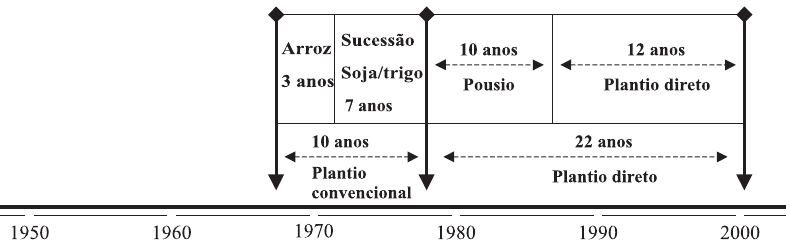
Figura 1. Representação gráfica do histórico da ocupação agrícola das terras pertencentes à Fazenda Santa Branca, com destaque para as áreas de